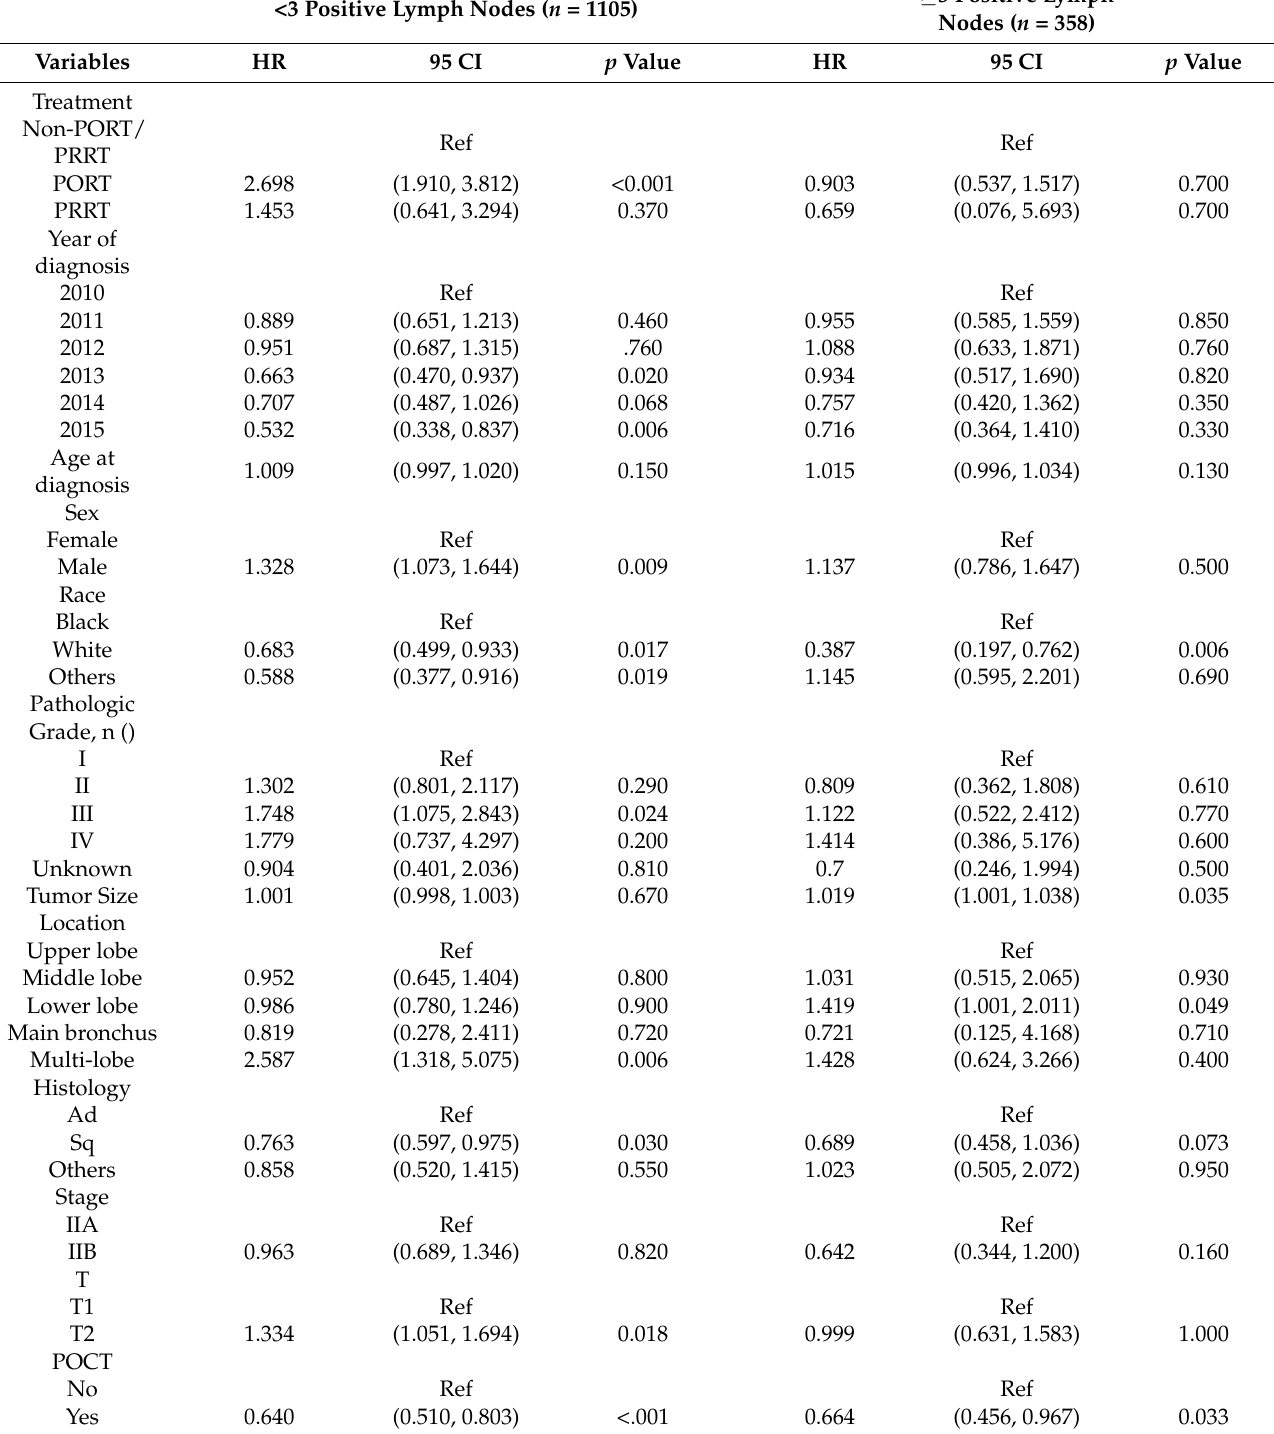
Table 2. Multivariate analysis of important variables affecting prognosis of patients in N1